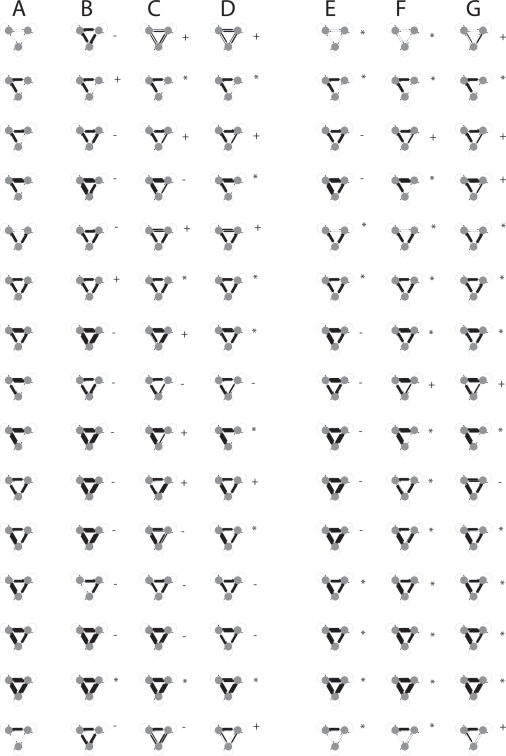
Typical offspring motifs produced by Mechanism A (column B) when copying parent motifs (column A).Read the figure by comparing the motifs in each column with the parent motif on the left column. Error correction mechanisms are introduced (EC1 in column C & EC1+EC2 in column D). Sparse activation is introduced in columns E, F and G. (Mechanism A = E, Mechanism B with EC1 only = F, Mechanism B with EC1+EC2 = G) Part A. Parental motifs. Part B. Control case. LTD<LTP type STDP with no error correction. Part C. As above but with error correction type 1. EC1 T = 10 ms. Part D. As above but with both types of error correction in use. EC1 T = 10 ms+EC2 S = 5 ms, ε = 0.01. Part E. Sparse activation. Control case. Part F. Sparse activation. EC1 T = 10 ms. Part G. Sparse activation. EC1 T = 10 ms+EC2 S = 5 ms, ε = 0.01. * = accurate copy, + = ‘semi-accurate copy’, − = erroneous copy (total error >30 mV).